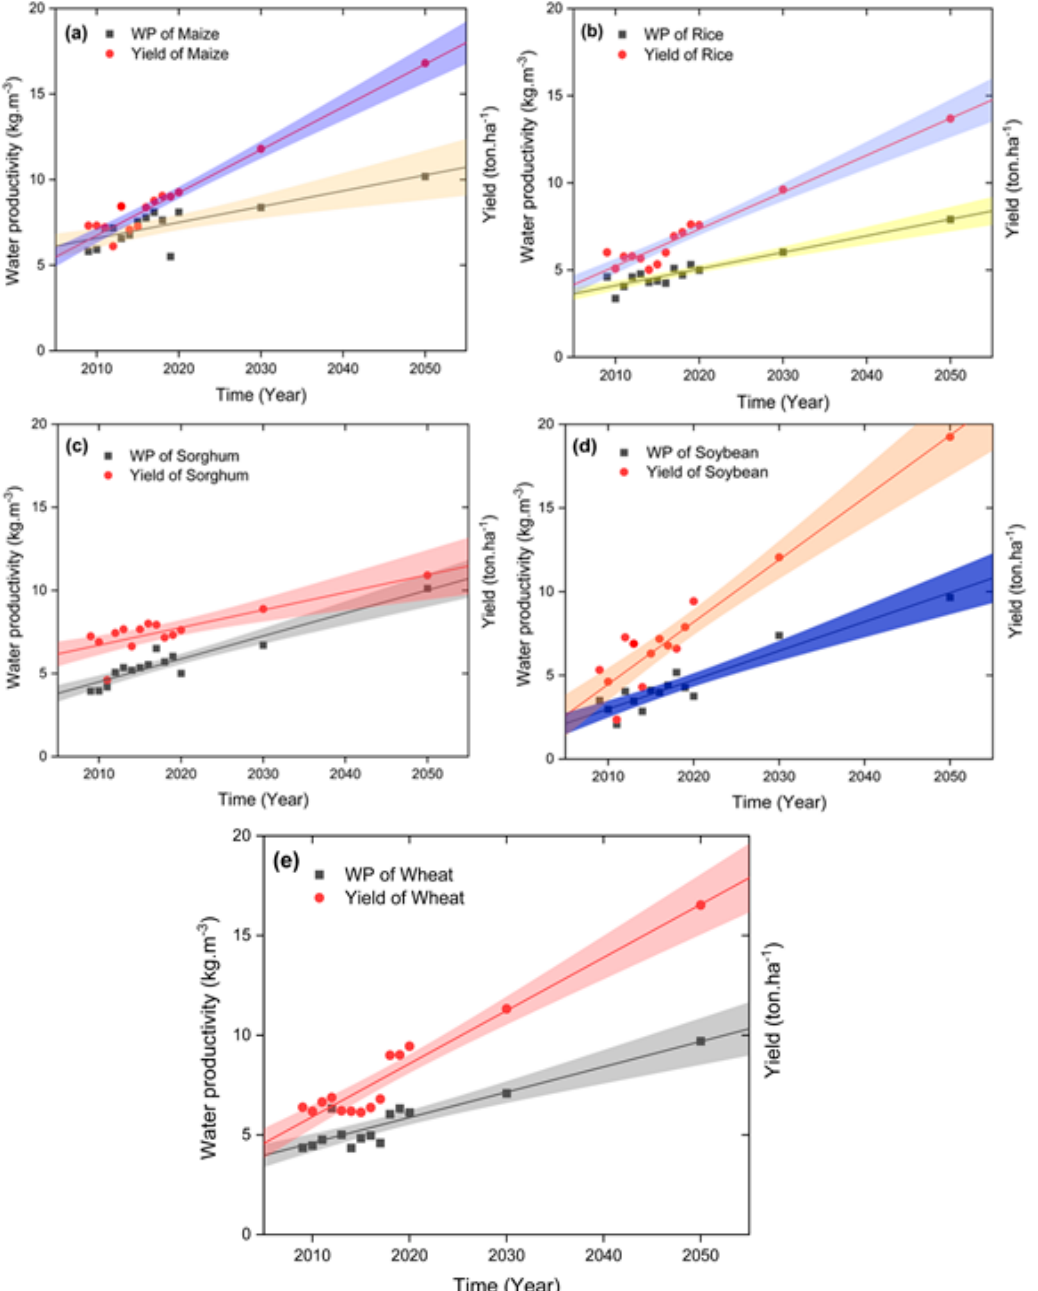
Figure 8. CWP and CY in NRB countries from 2009 to 2050. Cumulative of ( a ) Maize, ( b ) Rice, ( c ) ( c ) Sorghum, ( d ) Soybean, and ( e ) Wheat based on higher, average, and lower Sorghum, ( d ) Soybean, and ( e ) Wheat based on higher, average, and lower levels.